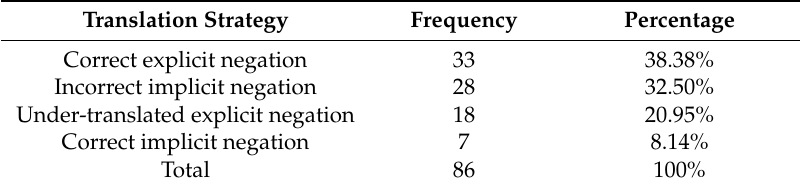
Table 5. Frequency and percentage of translation strategies for little determiner